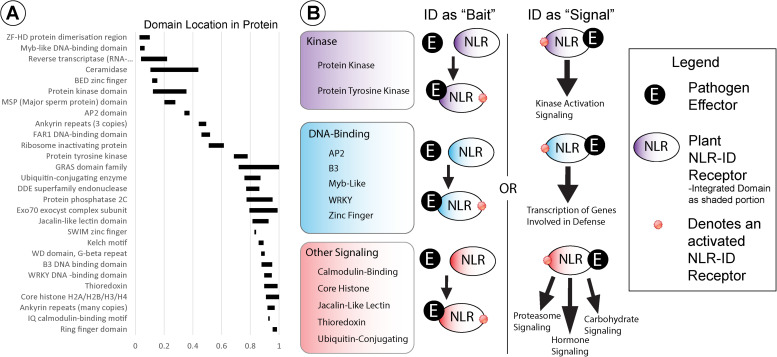
(A) Integrated domain (ID) locations, indicated by black rectangles, are shown within NLRs relative to protein length (0–1). (B) IDs were grouped into functional categories, based on their potential involvement in kinase, DNA-binding, or other signaling activities (shown in purple, blue, and red, respectively). Schematic diagrams representing potential functions for these NLR-IDs are included with pathogenic effectors represented by black circles and NLR-ID proteins as ovals color coded by ID type (i.e., “kinase,” “DNA-binding,” or “other signaling”), as shown in the figure legend. The diagram includes representations of the kinds of effector-bait interactions and NLR-ID signaling pathways in which these domains may be involved.